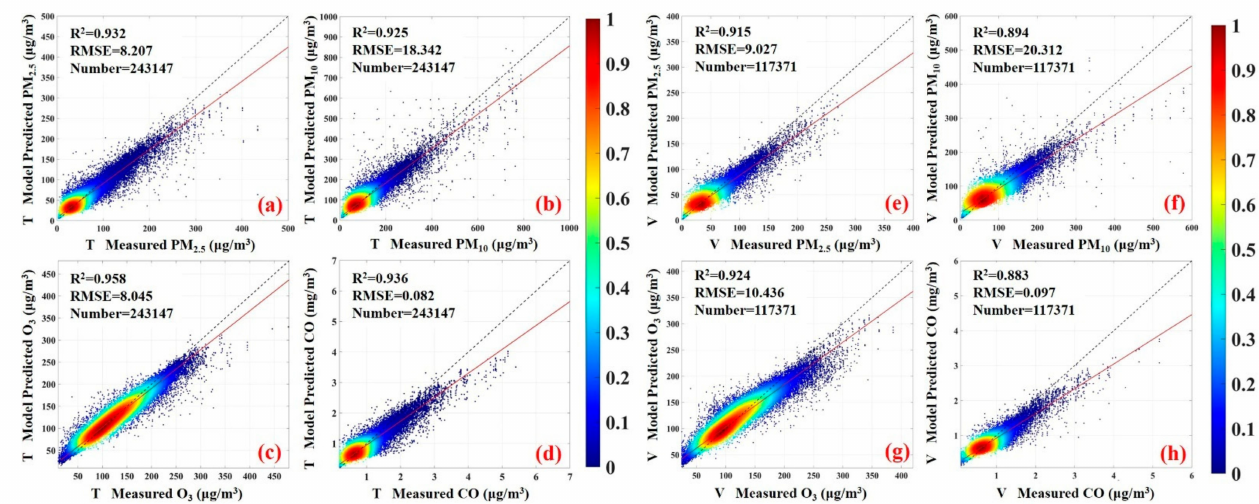
Figure 3. Density plots of daily PM 2.5 , PM 10 , O 3 , and CO concentrations for model training and independent validation. The results for ( a – d ) model training (2018–2019) and ( e – h ) independent validation (2020) for PM 2.5 , PM 10 , O 3 , and CO